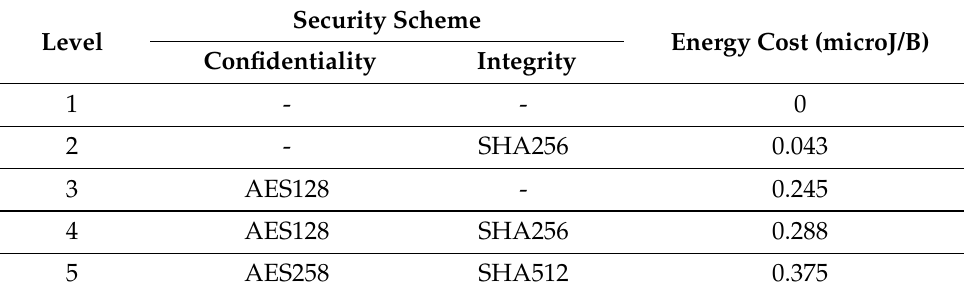
Table 5. Energy cost for the various security